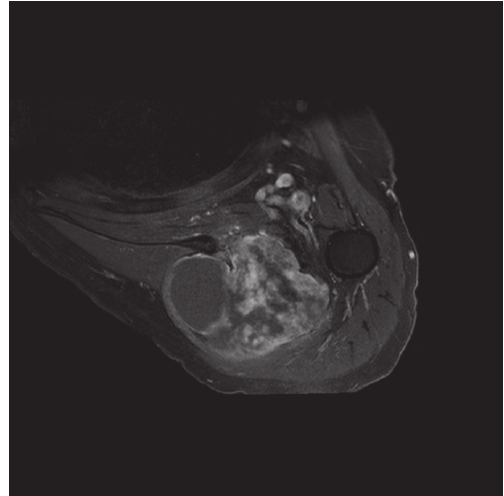
Figure 3: T1 transverse image with fat saturation after intravenous gadolinium injection. Note the enhancement indicating the pres- ence of a solid component inside the mass which in consequence is a pseudocystic mass.